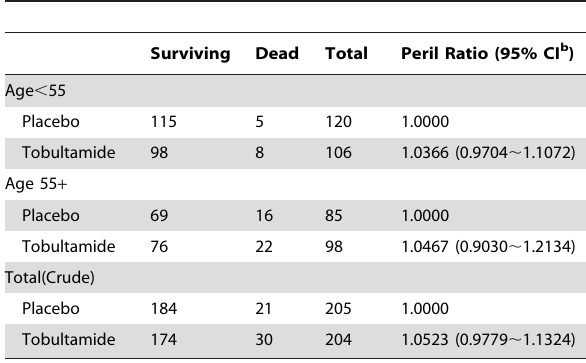
Table 1. Data layout for the i th stratum. Non-diseased Diseased